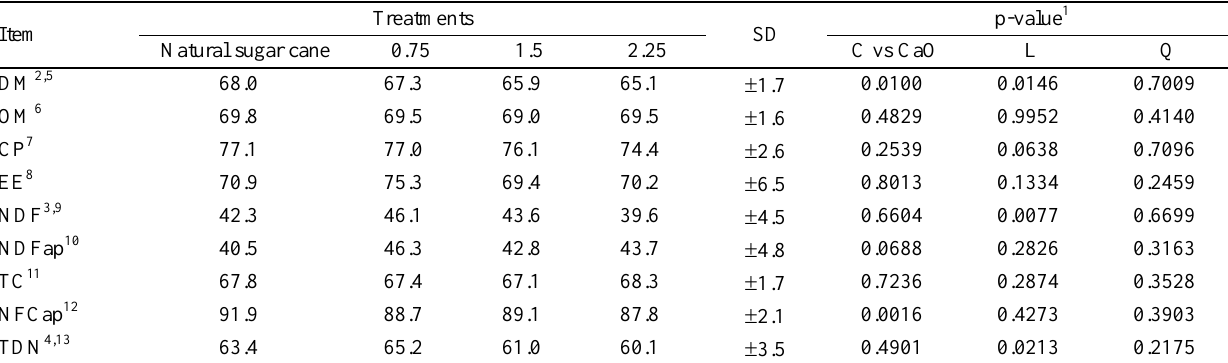
Table 5. Least square means, coefficients of variation (CV) and descriptive levels of probability for contrasts (p-value) of the digestibility of dry matter and nutrients in lambs fed diets containing natural sugar cane or sugar cane treated with calcium oxide (CaO) doses of 0.75, 1.5 and 2.25% (as-fed